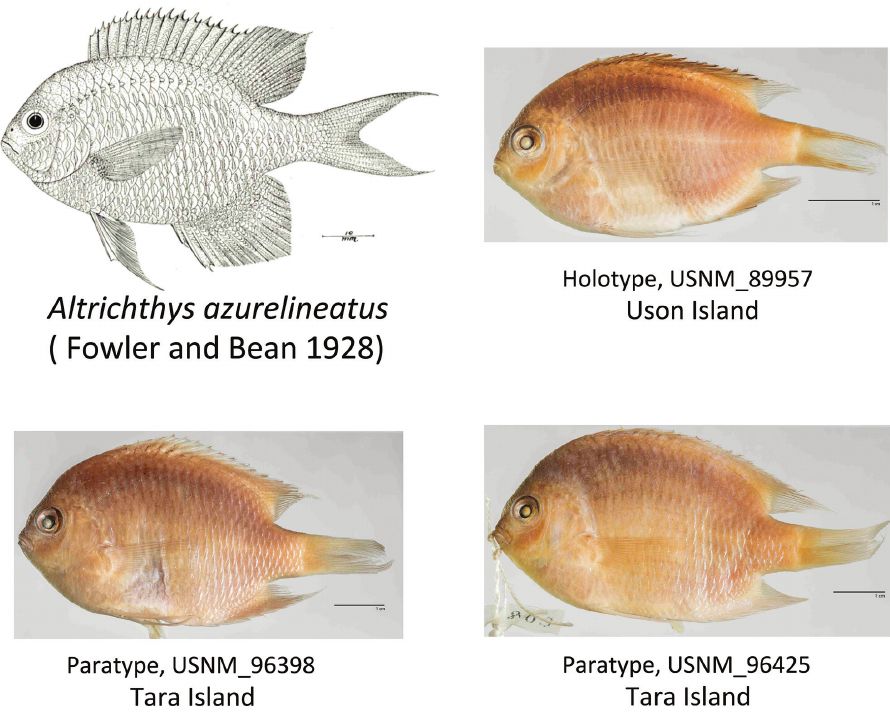
Figure 6. Drawing (upper left, from Fowler and Bean 1928) and photo (upper right) of the holotype of Altrichthys azurelineatus from Uson Island (USNM 89957), and paratypes (bottom photos) (USNM 96398, 96425) collected at Tara Island. Photos by Sandra J. Raredon, Division of Fishes, Smithsonian